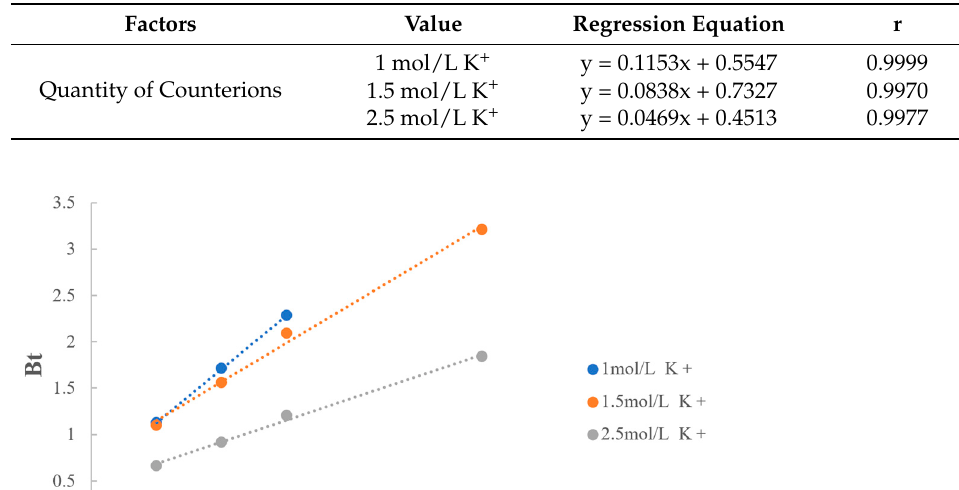
Table 11. Boyd model fitting on the concentration of counterions.